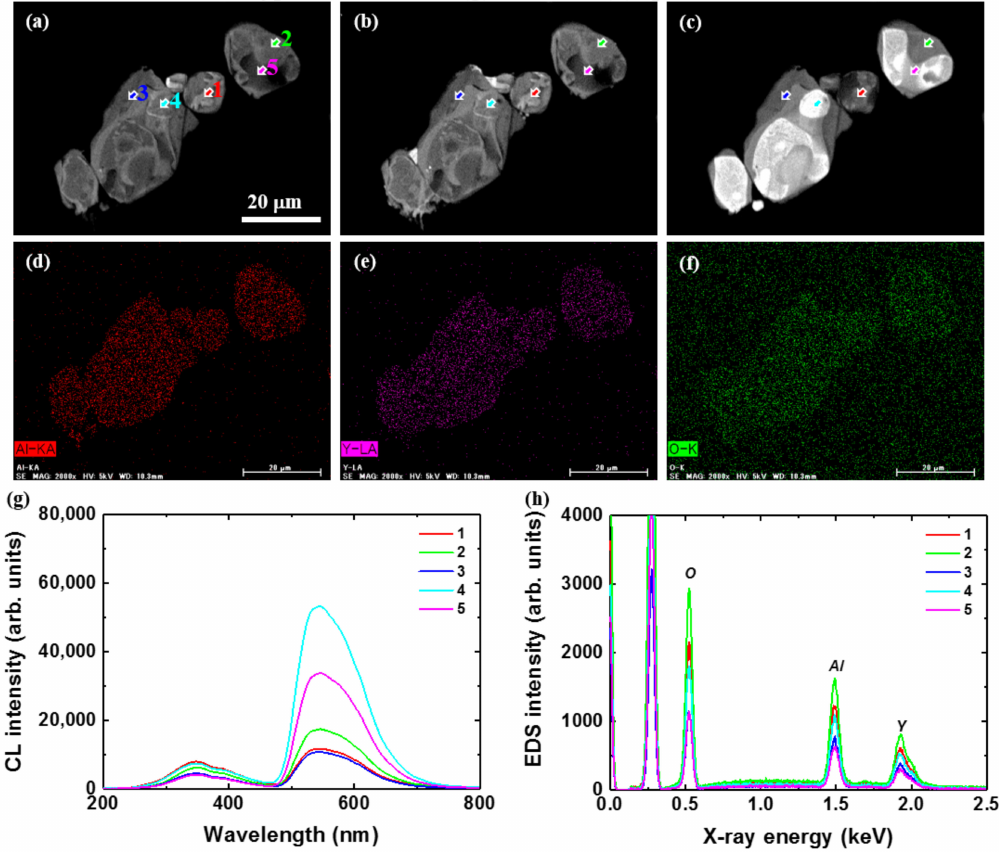
Figure 7. Cross-sectional CL images taken at 330 ( a ); 395 ( b ) and 540 nm ( c ) and Al ( d ); Y ( e ) and O ( f ) distributions for C@YAG:Ce 3+ -1500 ◦ C/Type A; Local CL ( g ) and Energy-Dispersed Spectroscopy (EDS) ( h ) spectra taken on locations indicated by arrows in the images. In the EDS spectra, the first peak at 0.25 keV is ascribed to the carbon from epoxy resin in the pre-treatment of cutting before doing cross-sectional CL